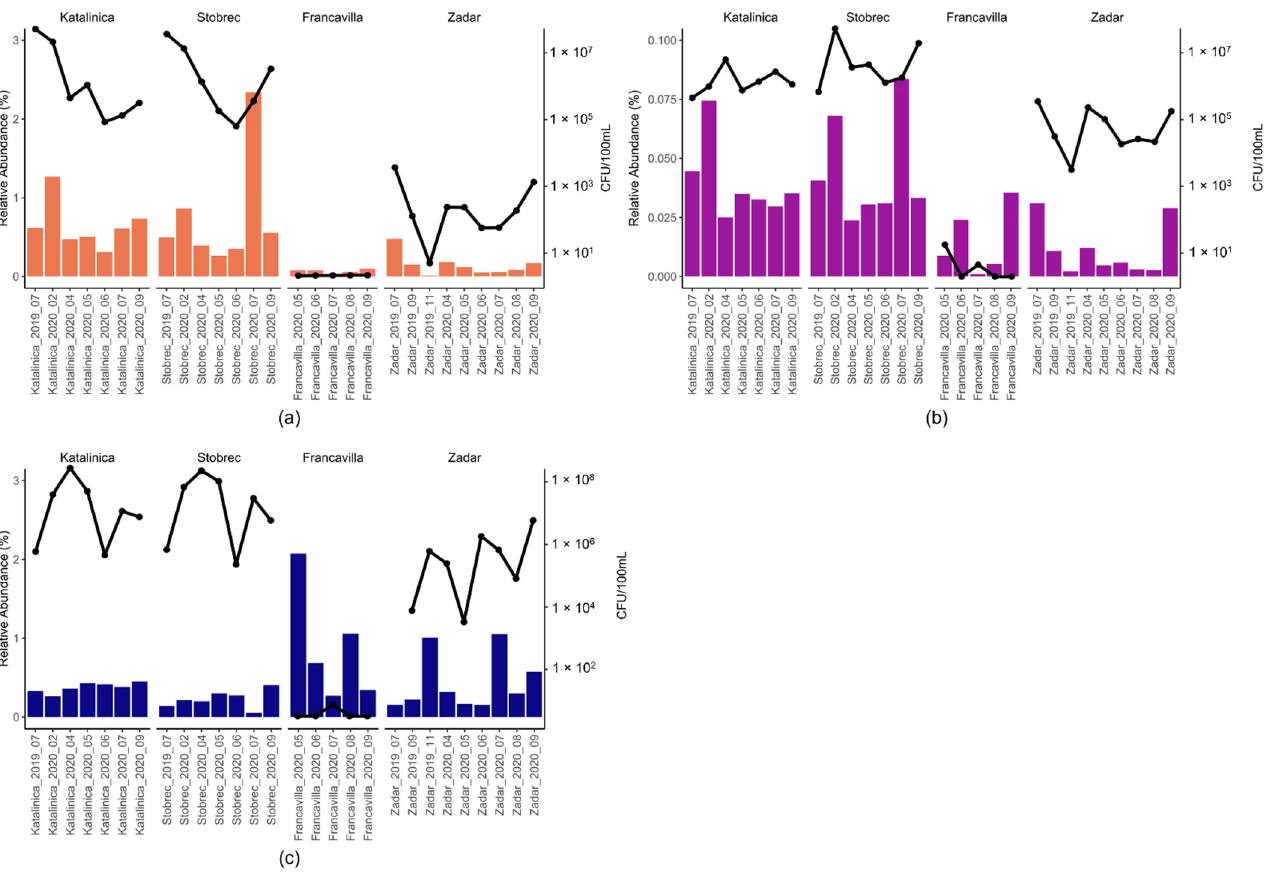
Figure 7. Comparison between 16S rRNA metagenetics data and plate count data for FIB and Pseudomonas aeruginosa . ( a ) Escherichia coli . ( b ) Enterococci. ( c ) P . aeruginosa . Plate count data are shown as solid black lines and 16S rDNA relative abundances as colored bars.